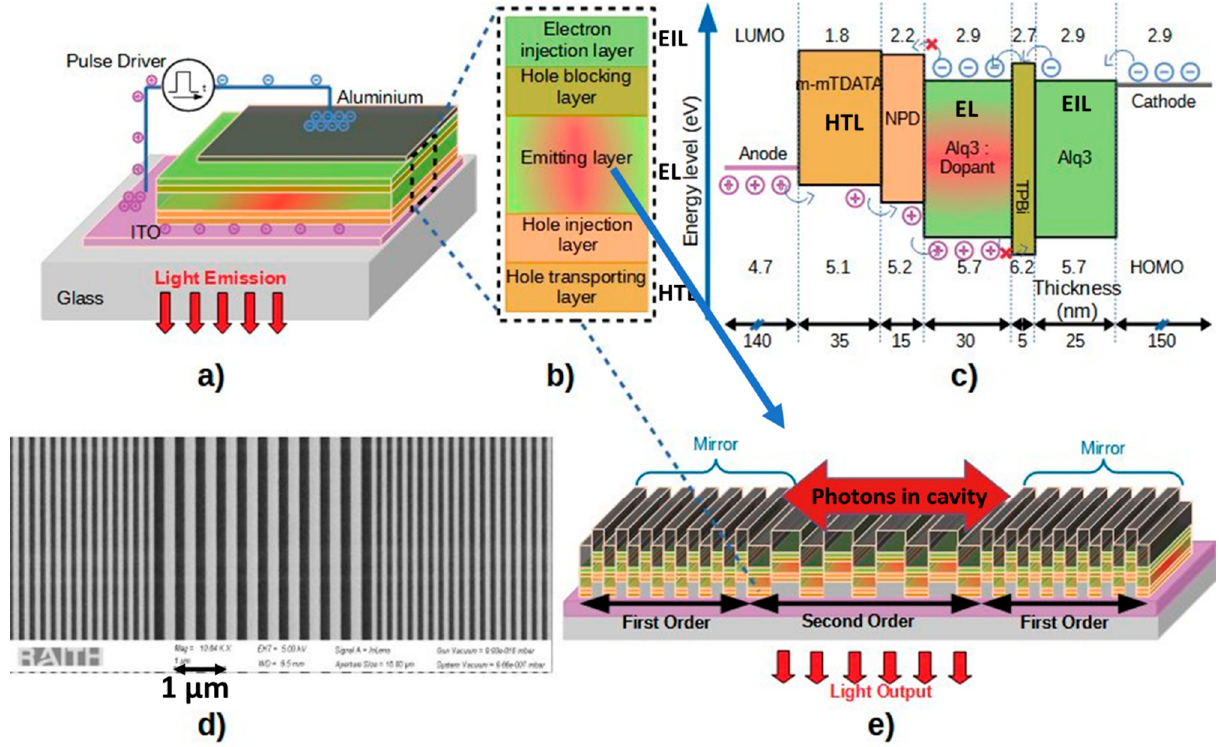
Figure 1. Schematics and direction of light emission of ( a ) the layer structure indicated in ( b ) with ( c ) the energy level diagram. In ( d ) a top view photograph is shown of the second-order grating sandwiched between the two first-order gratings and ( e ) presents a sketch of the OLD structure indicating the confined light between the mirrors formed by the first-order gratings.